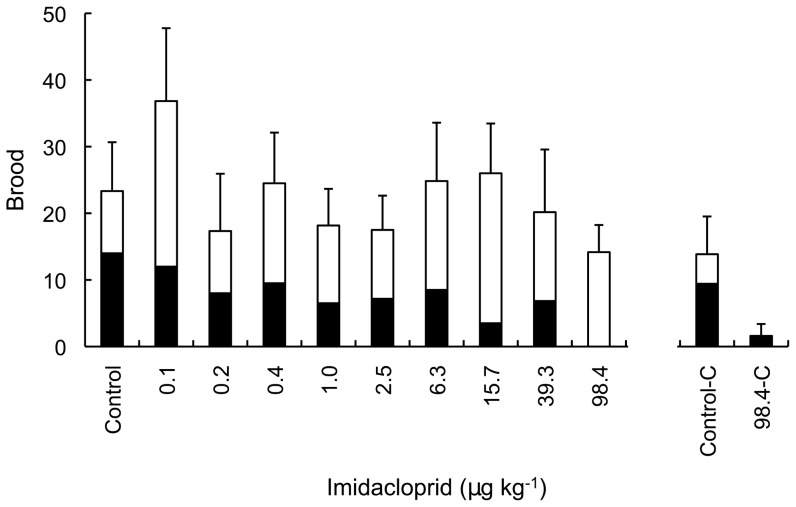
Brood production in Bombus terrestris colonies during a pulsed or continuous exposure to imidacloprid.Mean number of brood produced in standardised Bombus terrestris colonies (N = 60) during 28-day pulsed or continuous exposure to dietary imidacloprid. For pulsed exposure (from left to right, ‘Control’ to ’98.4’): brood produced during the 14-day ‘on dose’ period (black bars), during which colonies were exposed to imidacloprid in syrup at the specified dosage (in µg kg−1  =  parts per billion); and brood produced during the subsequent 14-day ‘off dose’ period (white bars), during which all colonies fed exclusively on control syrup. For continuous exposure (‘Control-C’ and ’98.4-C’): brood produced during first 14 days of exposure (black bars) and brood produced during second 14 days of exposure (white bars). Where a column does not contain a black bar or a white bar, zero brood were produced during days 1–14 or days 15–28, respectively. Error bars indicate ± SE of mean brood production over 28 days.